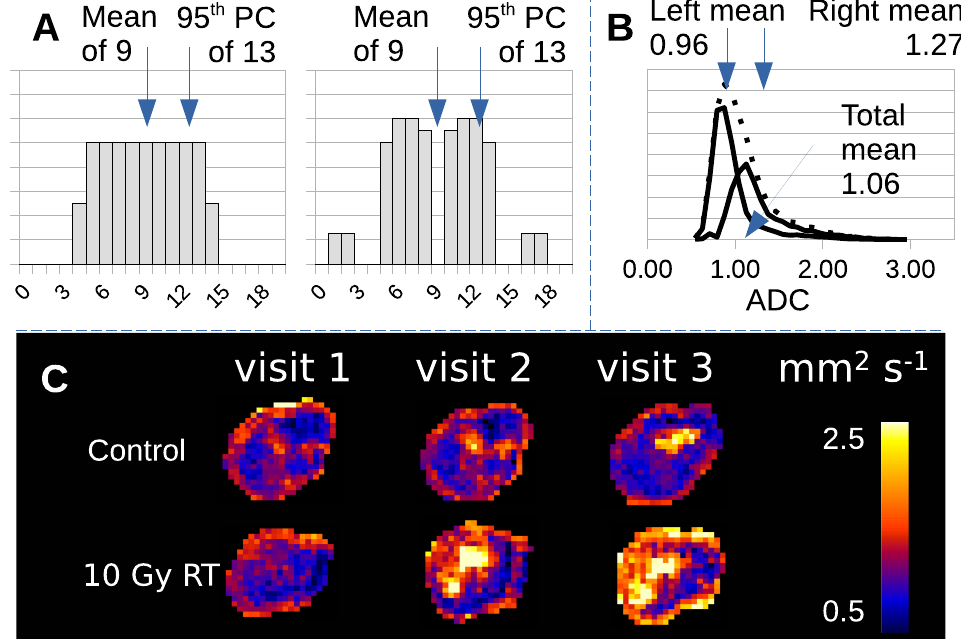
Figure 1. ( A ) Example of two data distributions (arbitrary units) that have the same mean, 95th percentile and integral, but are clearly different from one another. ( B ) Histogram of ADC data from a tumor treated with RT (dotted distribution) decomposed into treatment effect (left distribution) and no-effect components (right distribution). ( C ) ADC maps of control and RT treated Calu6 tumors have distinct habitats with different tumor